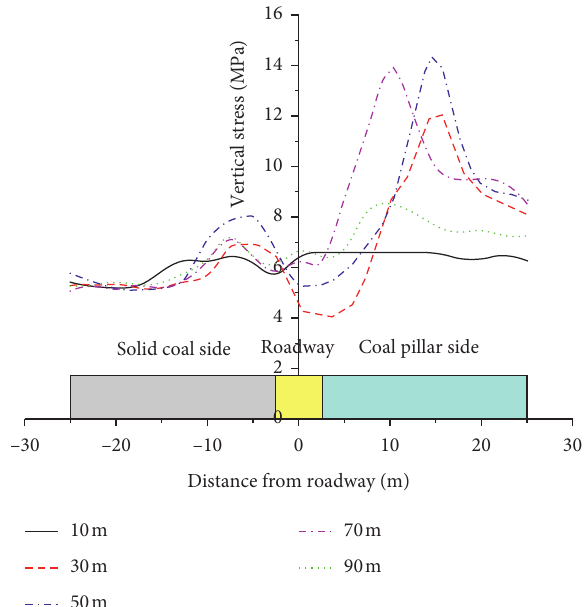
Figure 12: Lateral support stress distribution of roadway.